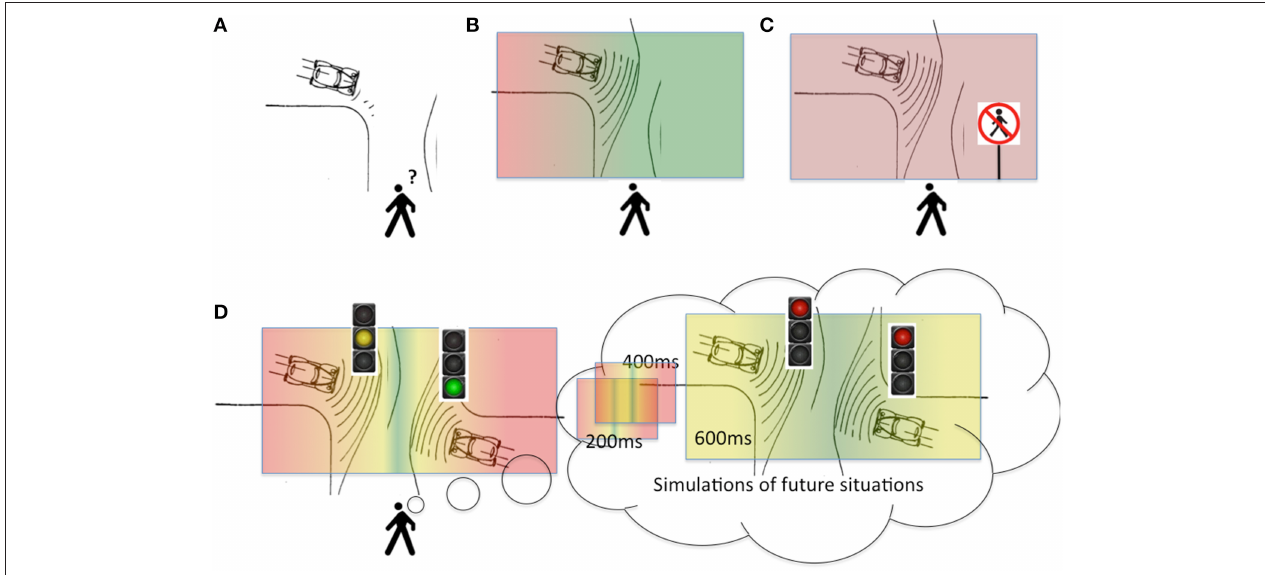
FIGURE 1 | How the affordance landscape changes as an effect of car movements and traffic signs. (A) An example situation: a pedestrian has to cross a road, with a car approaching. (B) The same situation, but now with the putative results of a predictive technology superimposed: here, the lines in front of the car represent its predicted future locations, and the colors represent a gradient of the “cross-ability” affordance (red = not crossable; green = crossable) ordered in a continuum. (C) The same situation with a traffic panel does not afford cross-ability anymore. (D) A more complex scenario, in which the predictive technology might simulate future simulated situations, e.g., display how the affordance landscape will change in the next 200, 400, and